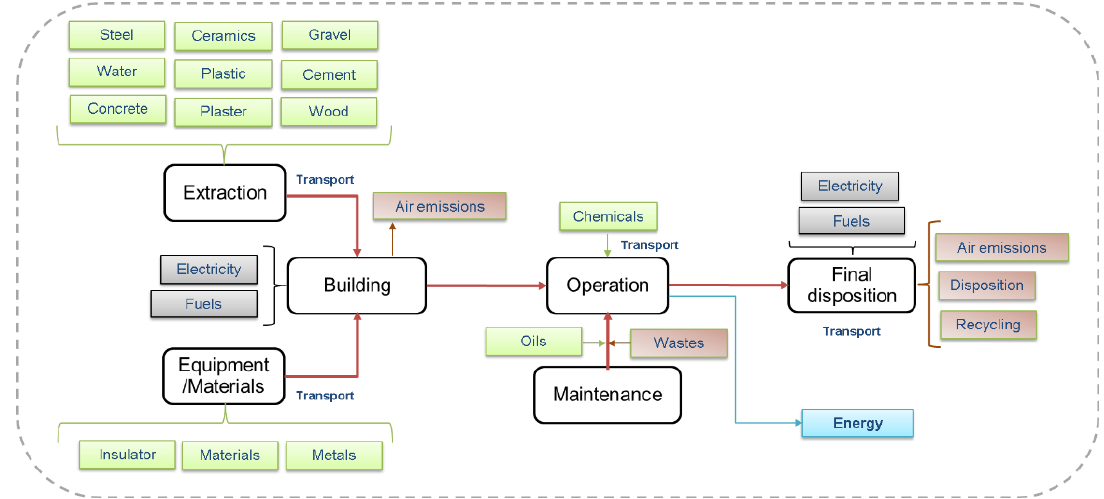
Figure 4. Overall schemes of life cycle inventory (LCI) of the energy ocean system.